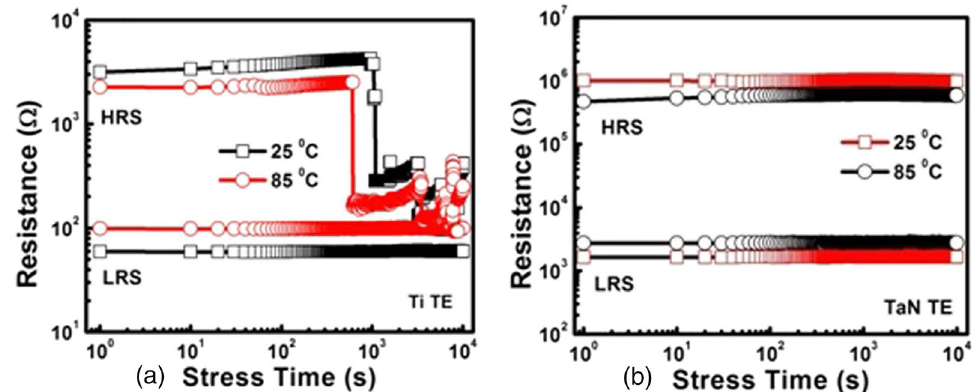
Fig. 12 Retention characteristics a Ti top electrode. b TaN top electrode. Reproduced with permission from